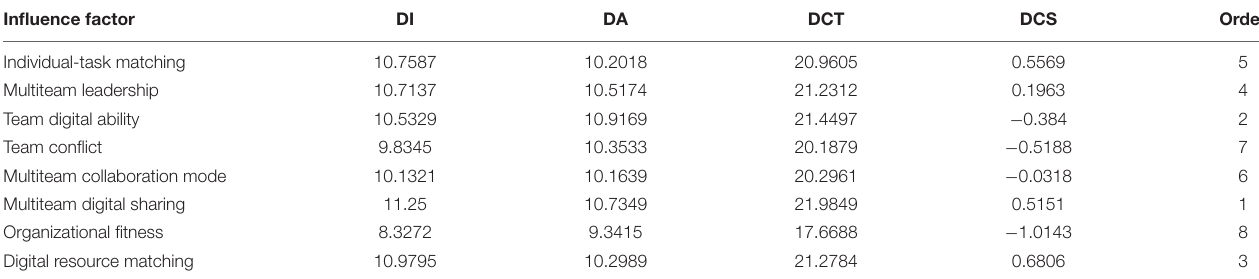
FIGURE 1 | Model of the factors influencing MTDC in the action phase. TABLE 3 | Calculation results of each degree in the action phase.